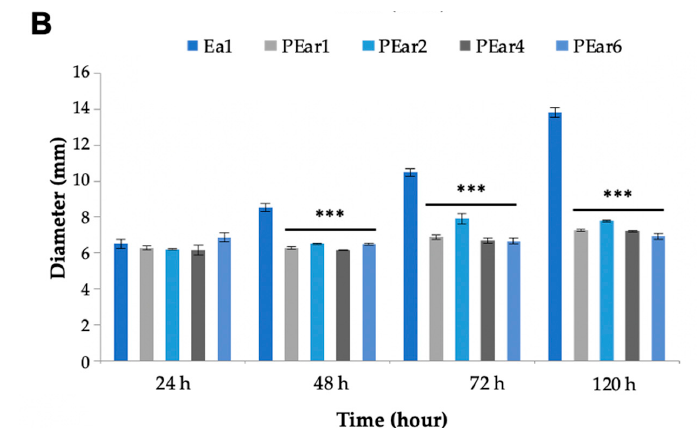
Figure 4. Swimming and swarming plates are affected by PEar infection. E. amylovora motility (( A )—swimming motility; ( B )—swarming motility) was evaluated 24, 48, 72 and 120 h after infection with the different PEar phages. An uninfected strain was taken as control. Bars represent the mean of three replicates ± SEM. The asterisks denote significant differences between the treatment groups and the control group ( p ≤ 0.001).